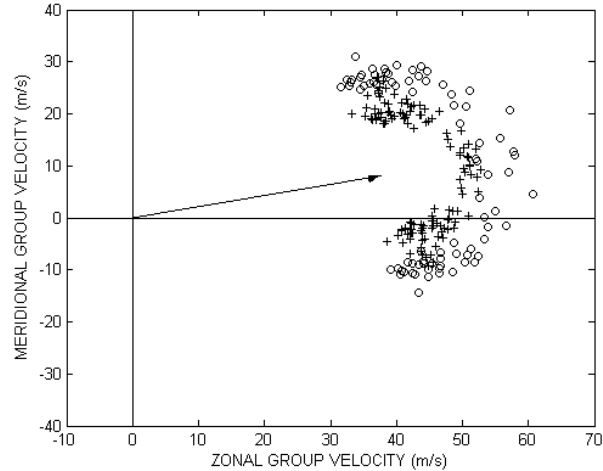
Fig.4 Scattering plot of the horizontal group velocities of the upward moving gravity Fig. 4. Scattering plot of the horizontal group velocities of the up- wave packets of winter data set. Wave packets obtained by windows T3aZ4, ward moving gravity wave packets of winter data set. Wave pack- T3bZ4 and T3cZ4 were denoted by ‘cross’ ; wave packets obtained by windows ets obtained by windows T3aZ4, T3bZ4 and T3cZ4 were denoted T3aZ5, T3bZ5 and T3cZ5 were denoted by ‘open circle’ . by cross; wave packets obtained by windows T3aZ5, T3bZ5 and T3cZ5 were denoted by open